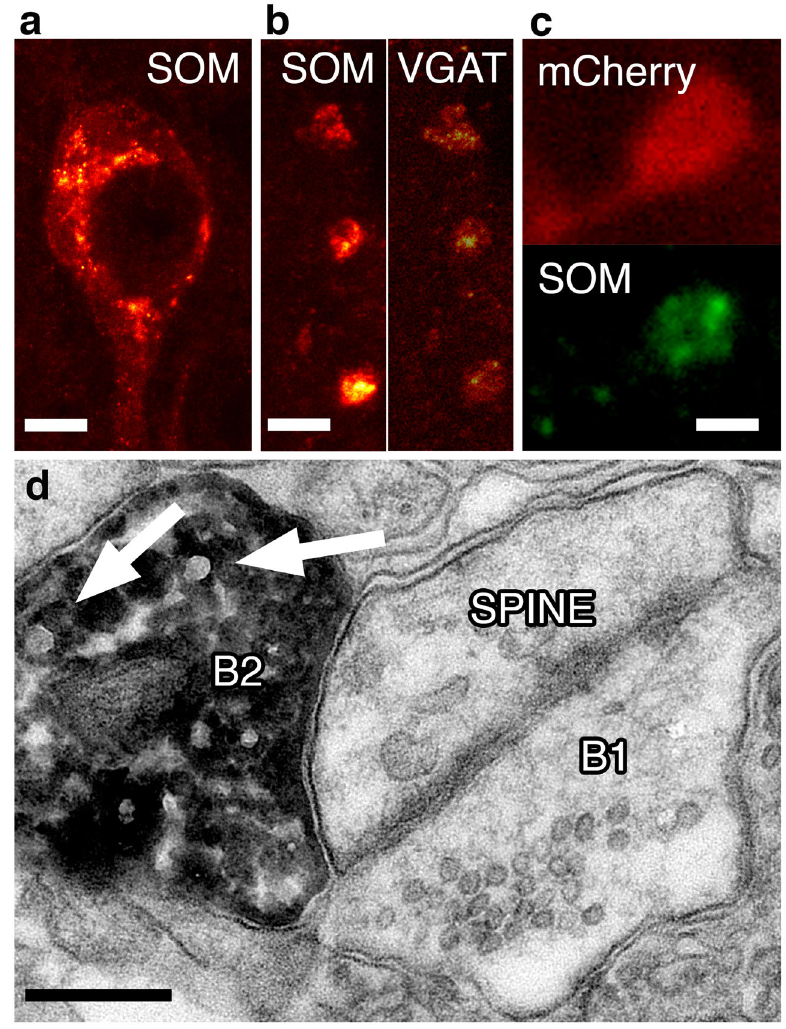
Fig. 4 The SOM neuromodulator peptide is synthetized in the somatic region and packed into synaptic vesicles. a STED image of SOM immunoreactivity in a soma in the MEC. Note the granular labeling of putative endoplasmatic reticulum surrounding the empty nucleus. Scale: 2 μ m. b SOM (left) and VGAT immunoreactivity detected with STED microscopy within the same synaptic boutons in MEC. Scale: 1 μ m. c STED images of a Cre- dependent mCherry/ChR2-expressing bouton in the MEC of a SOM-Cre animal (top, red). SOM immunoreactivity in the same bouton shows granular, putative synaptic vesicle localization (bottom, green). Scale: 0.5 μ m. d Electron microscopic image of a spine in layer II of the MEC innervated by two different type of boutons. B1 is a putative excitatory bouton with similar-sized synaptic vesicles. B2 is a bouton of mCherry/ChR2 (DAB precipitate) expressing SOM + interneuron. Note the larger-sized synaptic vesicles (arrows) occurring among the normal-sized vesicles. Scale: 200